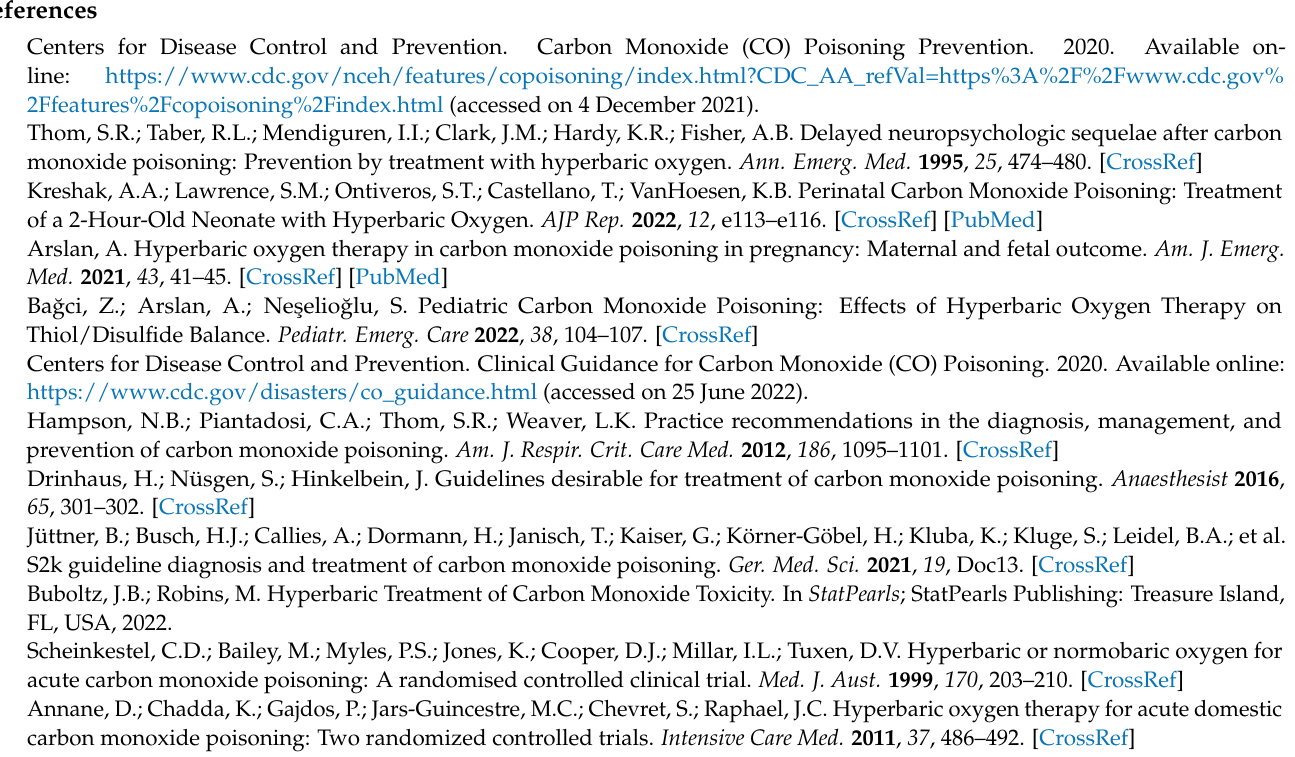
test for fatigue; Figure S9. Surface under the cumulative ranking curve of memory impairment; Figure S10. Inconsistency test of memory impairment; Figure S11. Small study effect test for memory impairment; Figure S12. Surface under the cumulative ranking curve of concentration impairment; Figure S13. Inconsistency test of concentration impairment; Figure S14. Small study effect test for concentration